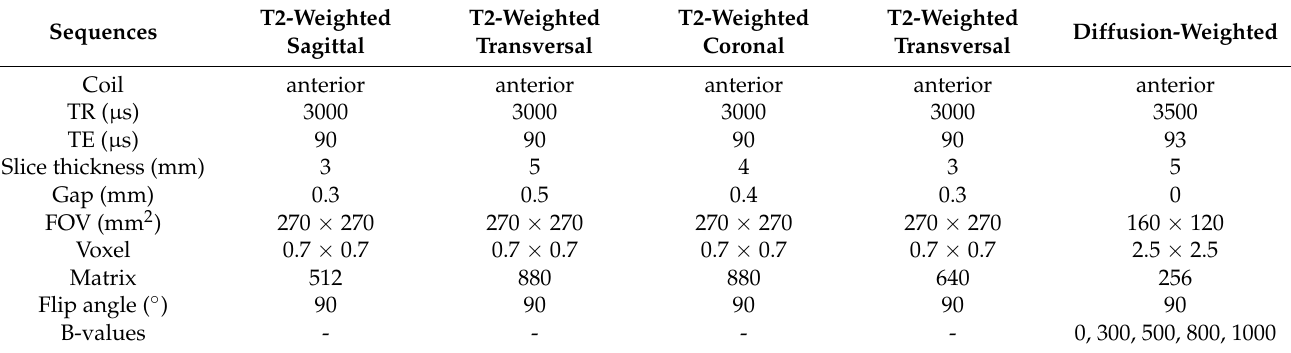
Table 1. Magnetic resonance imaging scanning protocol